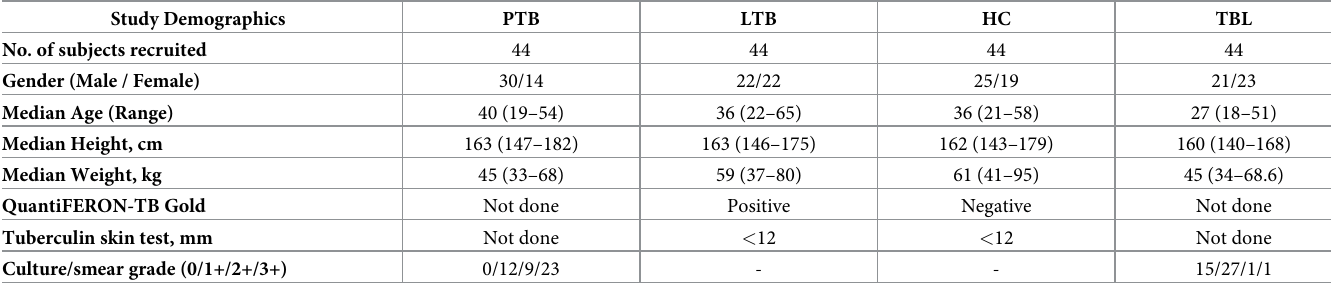
Table 1. Demographics of the study population.